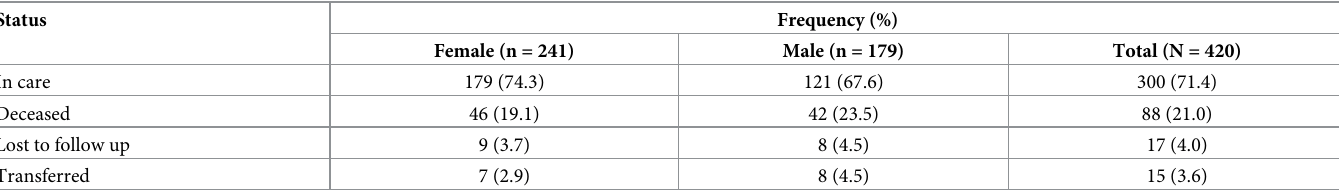
Table 2. Retention in care and attrition of a cohort of older people enrolling for ART at Newlands Clinic.